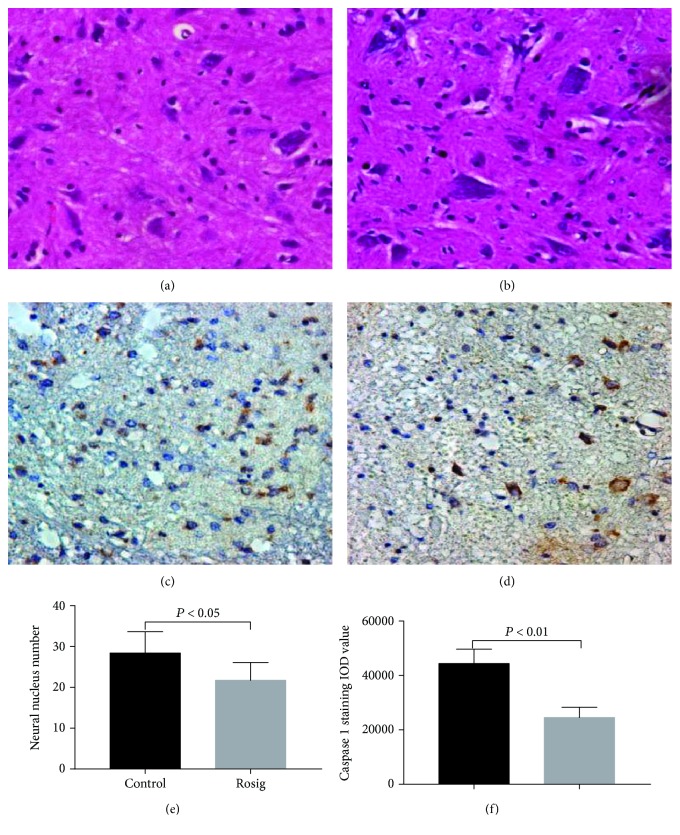
Representative HE staining in the ventral horn of the rat spinal cord and representative caspase-1 staining in the ventral horn of the rat spinal cord (40x). (a, b) Nissl bodies were visible in some neurons. (c, d) The positive staining mainly localized in the cytoplasm, but a small amount of positive staining was also observed in some nuclei (dark brown is the positive staining). (e) The number of neural nuclei in the rosiglitazone group was higher than that of the control group. (f) The expression of caspase-1 in the rosiglitazone group was lower than that in the control group. Data are expressed as mean ± SD (n = 6).